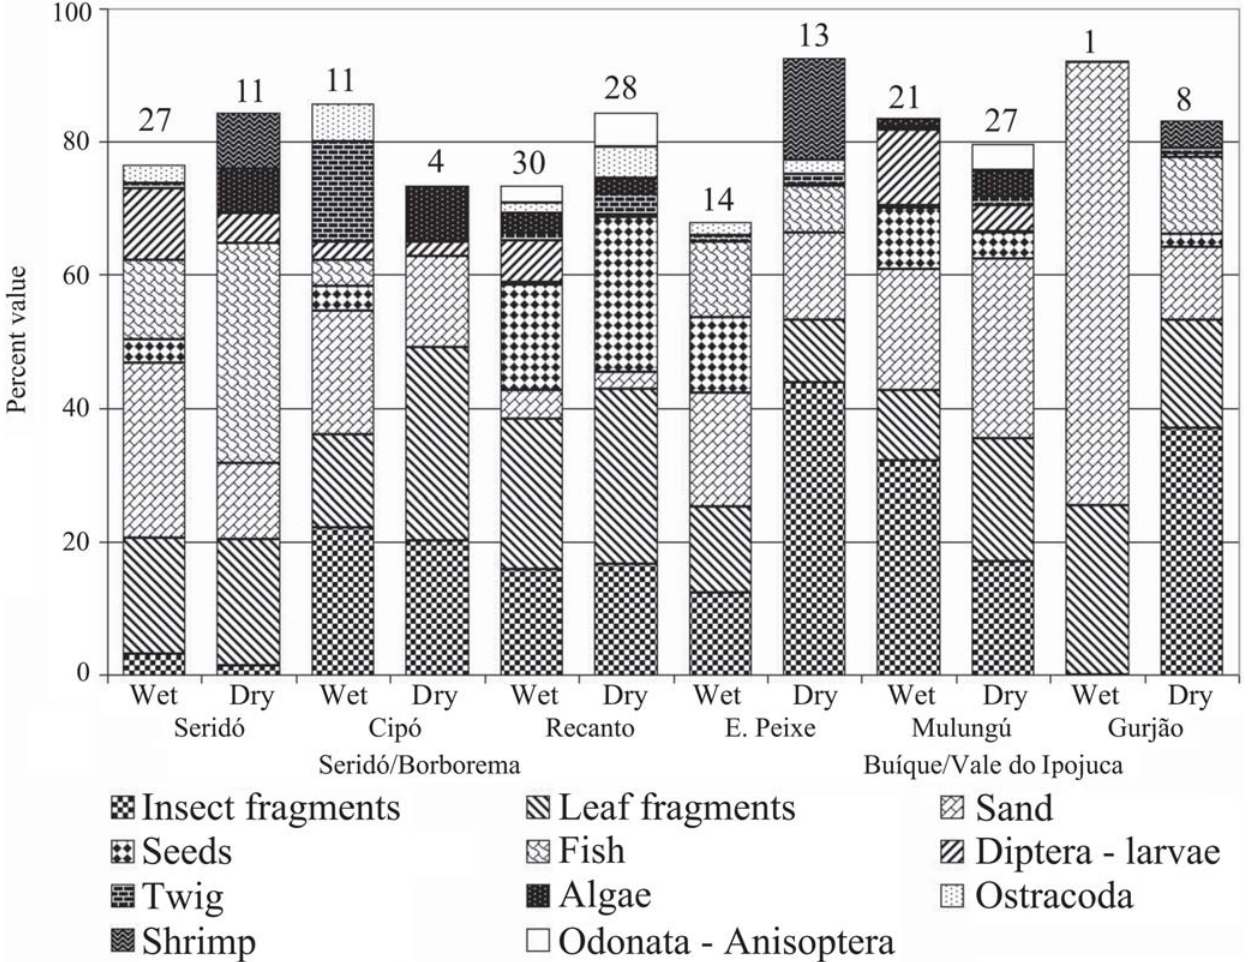
Fig. 3. Percentage composition of main food items to the diet of Astyanax aff. bimaculatus . Number of stomachs used (>20% fullness) is shown above each